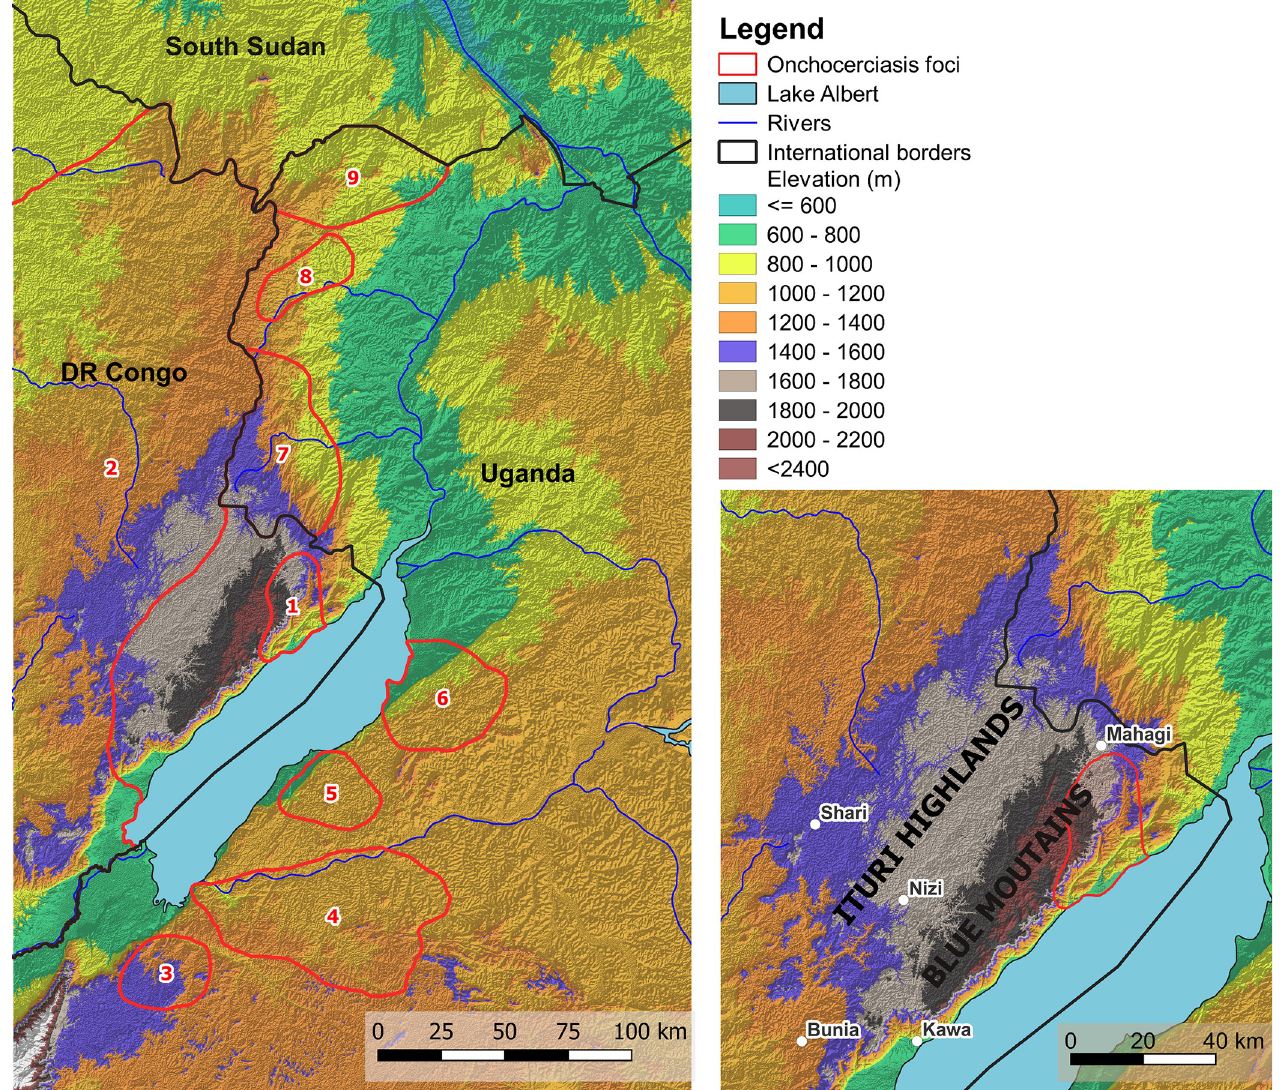
Fig 1. Relief map showing location of the Kakoi-Koda focus and other nearby foci. 1 = Kakoi-Koda focus; 2 = North-Eastern DRC Oncho Endemic Area; 3 = Itwara focus; 4 = Mpamba-Nkusi focus; 5 = Wambabya-Rwamarongo focus; 6 = Budongo focus; 7 = Nyagak-Bondo focus; 8 = Maracha-Terego focus; 9 = West Nile focus. Location of onchocerciasis foci according to Katabarwa et al. [29] and Makenga Bof et al. [8]. (Produced in QGIS: [50]). The RASTER images used to produce Fig 1 are Landsat-7 and Landsat-8 images, courtesy of the U.S. Geological Survey (https://www.usgs.gov/). The basic shapefiles for administrative areas can be found on the Re´fe´rentiel Ge´ographique Commun for the DRC (www.rgc.cd).